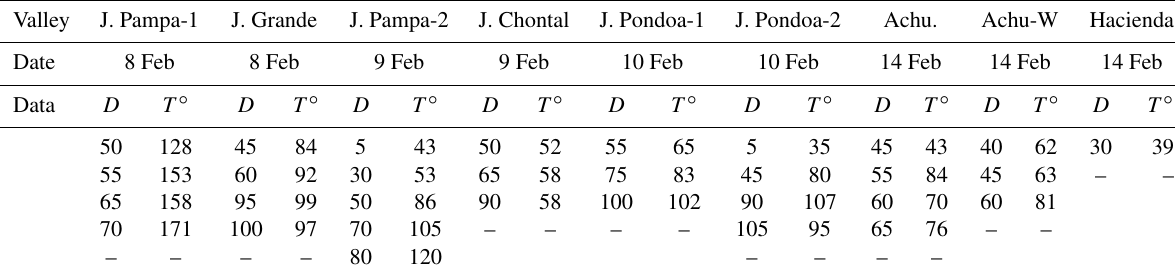
Table 4. Temperature profiles within final PDC deposit lobes. Valley